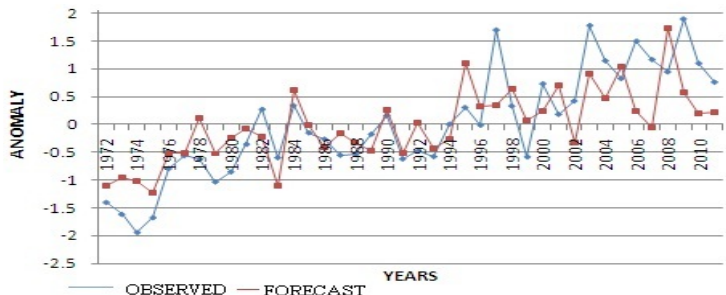
Figure 15. Graph of regression model results for Equation (4).